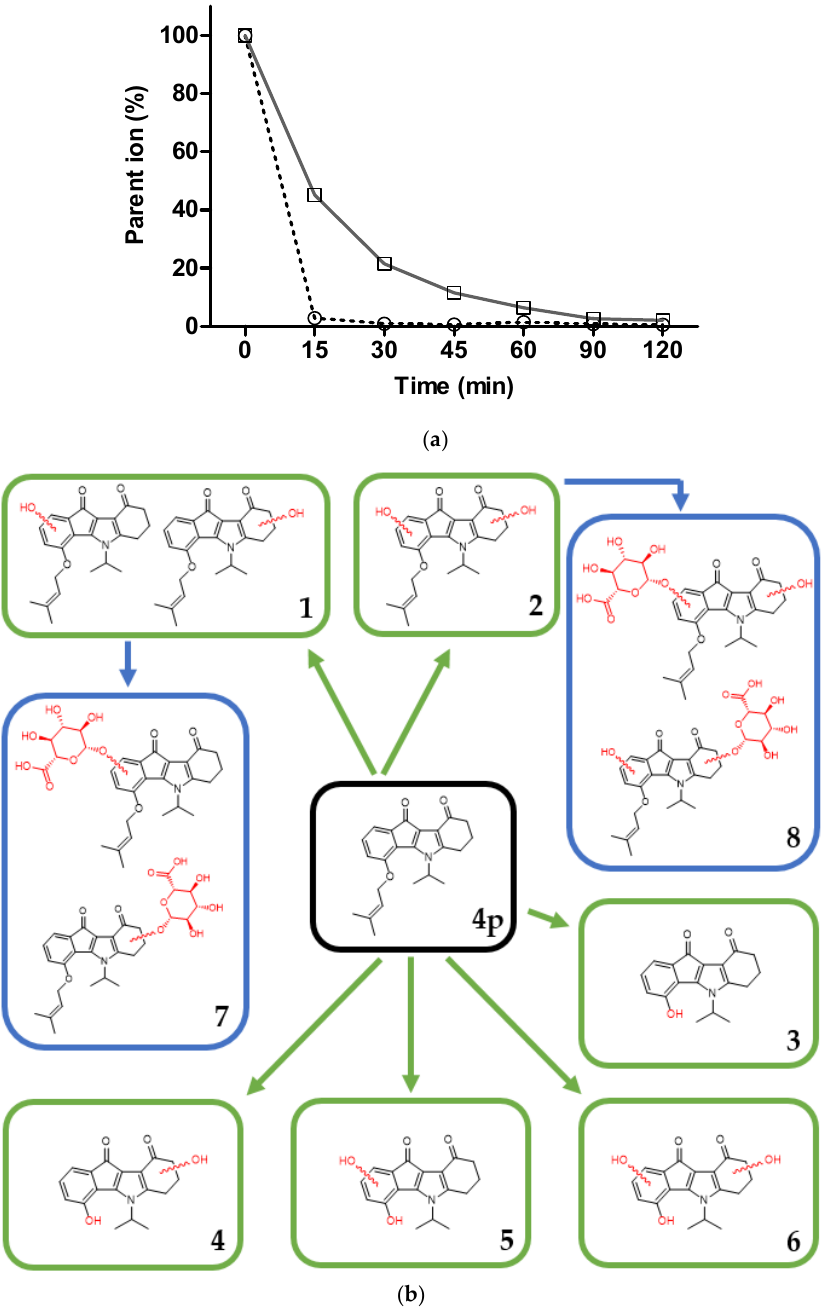
Figure 8. In vitro metabolism study of 4p . ( a ) Metabolic stability profile of 4p (dashed line) compared to that of imipramine (solid line). Both compounds were incubated with mouse liver microsomal fractions and NADPH for 120 min. The disappearance of the parent ion over time was measured in LC-MS/MS and normalized to the amount of parent ion at the start of the incubation (t = zero). ( b ) Schematic presentation of major identified metabolites of 4p as elucidated from MS spectra following incubation with mouse liver microsomes and cofactors for phase I metabolism enzymes (green rectangles) and UDPGA to study glucuronidation (blue